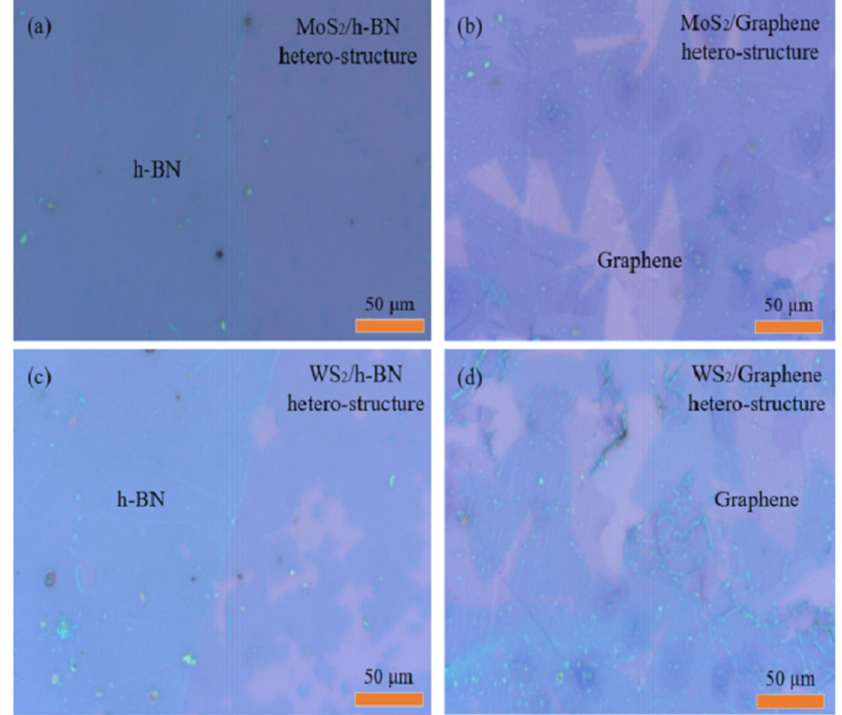
Figure 1. Optical micrograph of ( a ) MoS 2 /h-BN, ( b ) MoS 2 /graphene, ( c ) WS 2 /h-BN, ( d ) WS 2 /graphene heterostructures at different positions on SiO 2 /Si substrate.